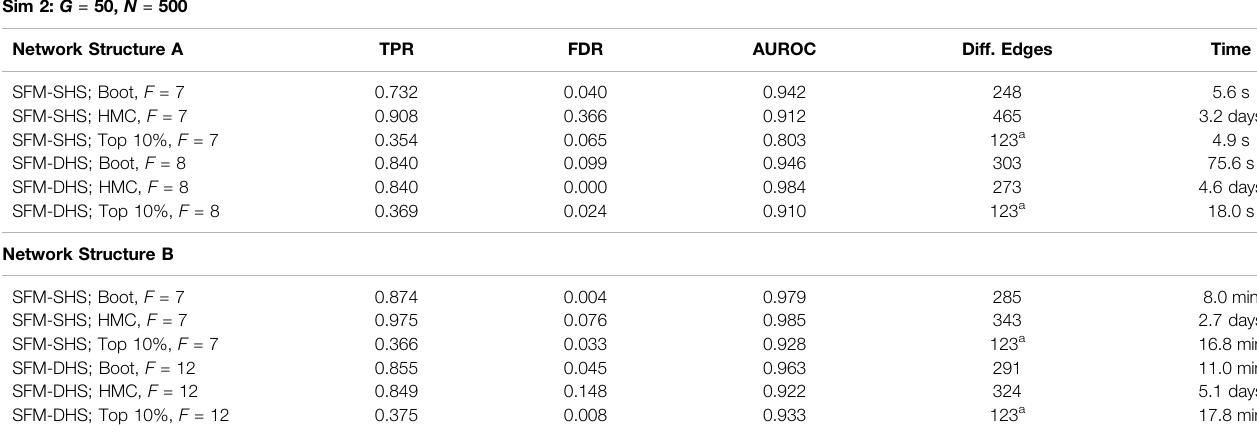
TABLE 3 | Results for SFM-SHS and SFM-DHS when utilizing bootstrap (Boot), HMC, and the Top 10% of differential edges from a single optimization. Times for Boot represent the average time of one posterior optimization of a single resampled dataset; similarly, HMC time is the average time for a single MCMC chain. Sim 2: G = 50, N = 500 Network Structure A TPR FDR AUROC Diff. Edges